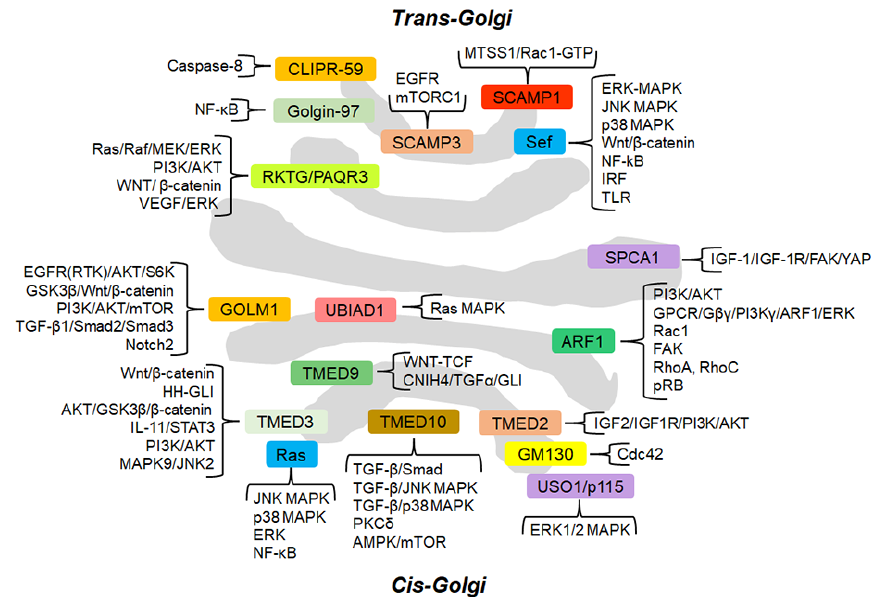
Figure 1. Schematic representation of the GC and GC-localized proteins (approximately in their localization) involved in cancer-related signaling pathways. The signaling cascades modulated by GC-proteins are grouped and briefly described. For the details of the molecular mechanisms through which the GC-localized proteins regulate the signaling pathways, the reader is referred to the text.